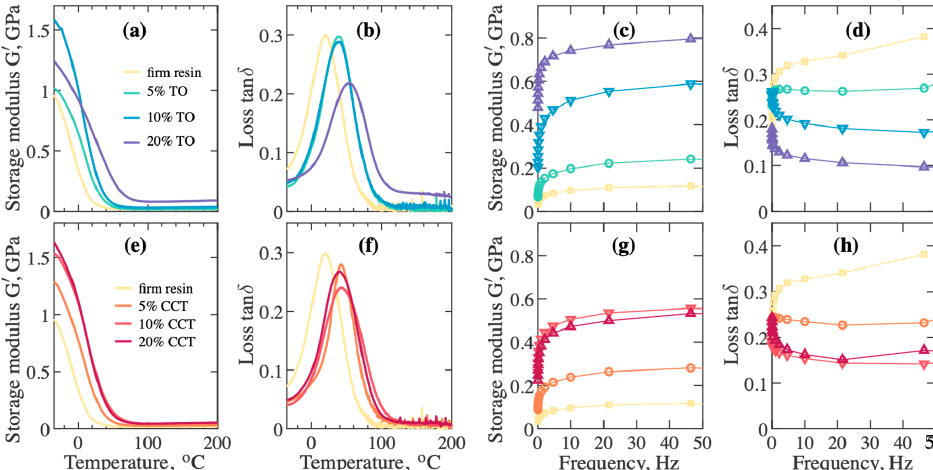
Figure 8. Temperature dependent storage modulus, G’, for 3DP ( a ) TO composite, and ( e ) CCT composite; loss factor tan δ , for ( b ) TO composite, and ( f ) CCT composite; frequency dependent G’ for 3DP ( c ) TO composite, and ( g ) CCT composite; and tan δ for ( d ) TO composite, and ( h ) CCT composite.